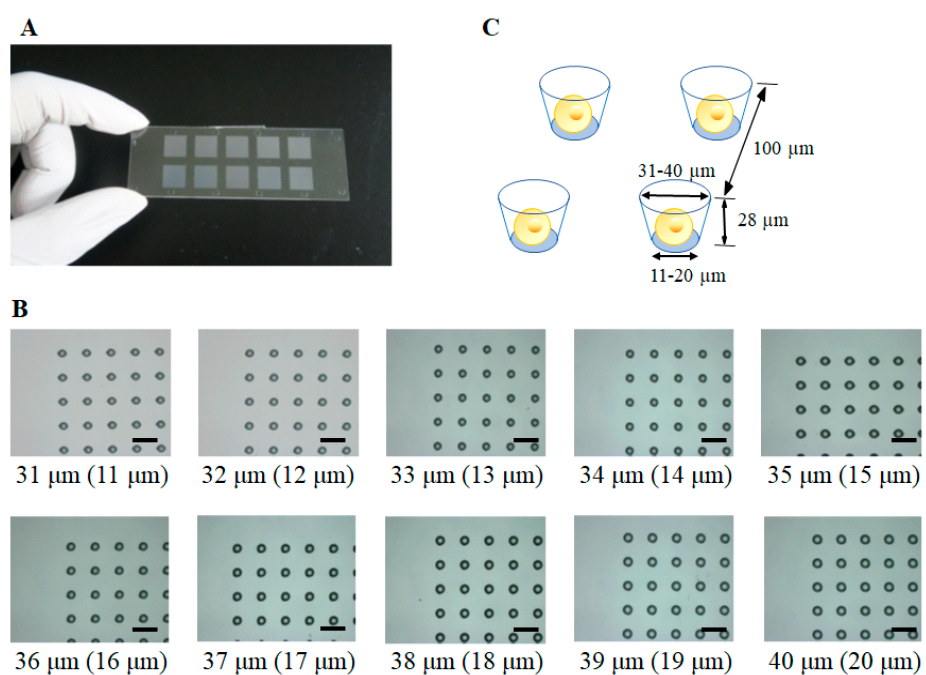
Figure 1. Construction of single-cell microarray chip. ( A ) Photo of a real single-cell microarray chip device, which is made of polystyrene and consists of 62,410 microchambers (31–40 µm upper diameter, 11–20 µm lower diameter, 28 µm depth, 100 µm pitch). Each single-cell microarray chip consisted of 10 different size patterns of clusters, and each cluster consisted of 6241 (79 × 79) microchambers. Each microchamber has the shape of a circular cone frustum; ( B ) Microscopic image of different sizes of microchambers (31–40 µm upper diameter) in the single-cell microarray chip. The size of picture ( B ) shows the upper diameter and lower diameter in brackets. Bars correspond to 100 µm; ( C ) Schematic of single cells confined to microchambers.